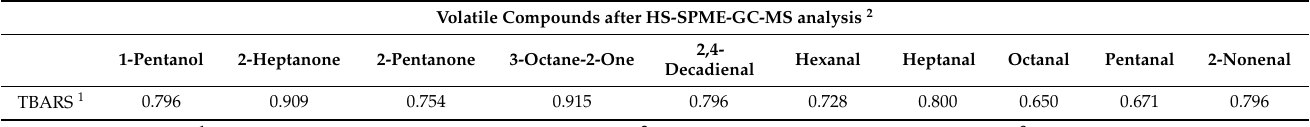
Table A3. Correlation r s between TBARS and individual volatile compounds (1-pentanol, 2-heptanone, 2-pentanone, 3-octane-2-one, 2,4-decadienal, hexanal, heptanal, octanal, pentanal, 2-nonenal) 3 . Volatile Compounds after HS-SPME-GC-MS analysis 2